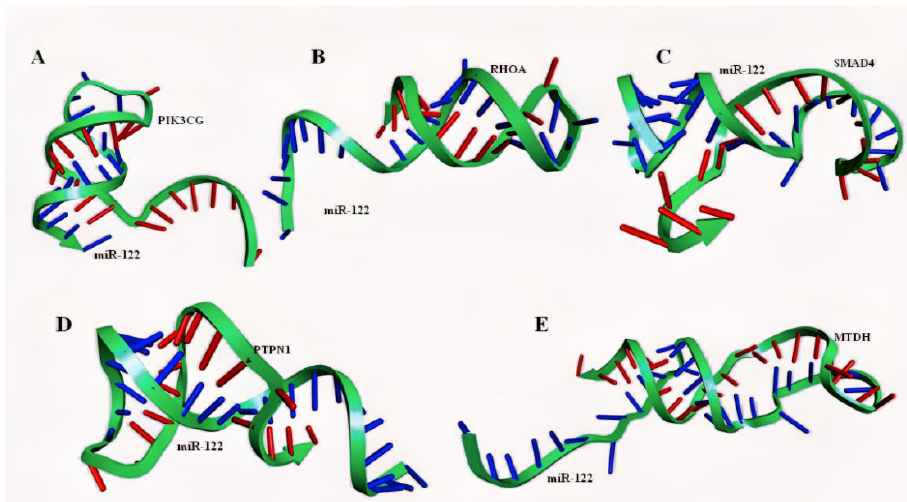
Figure 8. mRNA–miRNA duplexes; (blue: miRNA; red: mRNA of gene interactor) ( A ) miR-122–PIK3CG duplex; ( B ) miR-122–RHOA duplex; ( C ) miR-122–SMAD4 duplex; ( D ) miR122–PTPN1 duplex; ( E ) miR-122–MTDH duplex.